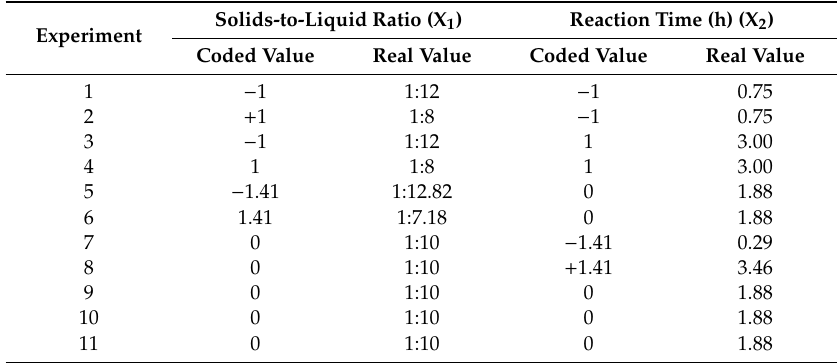
Table 1. Variables and levels evaluated in the optimization of oil and protein extraction in the aqueous extraction process (AEP) of almond